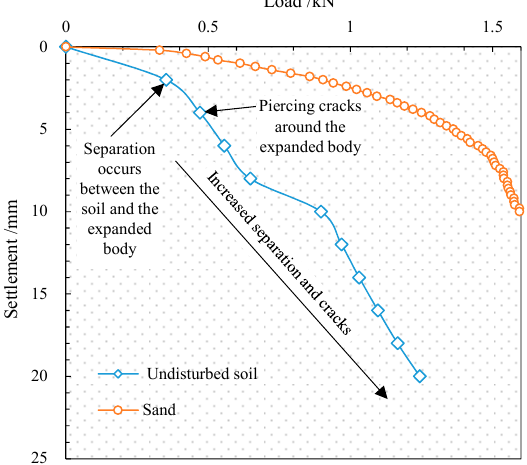
Figure 8. Load and settlement of pile top curve.